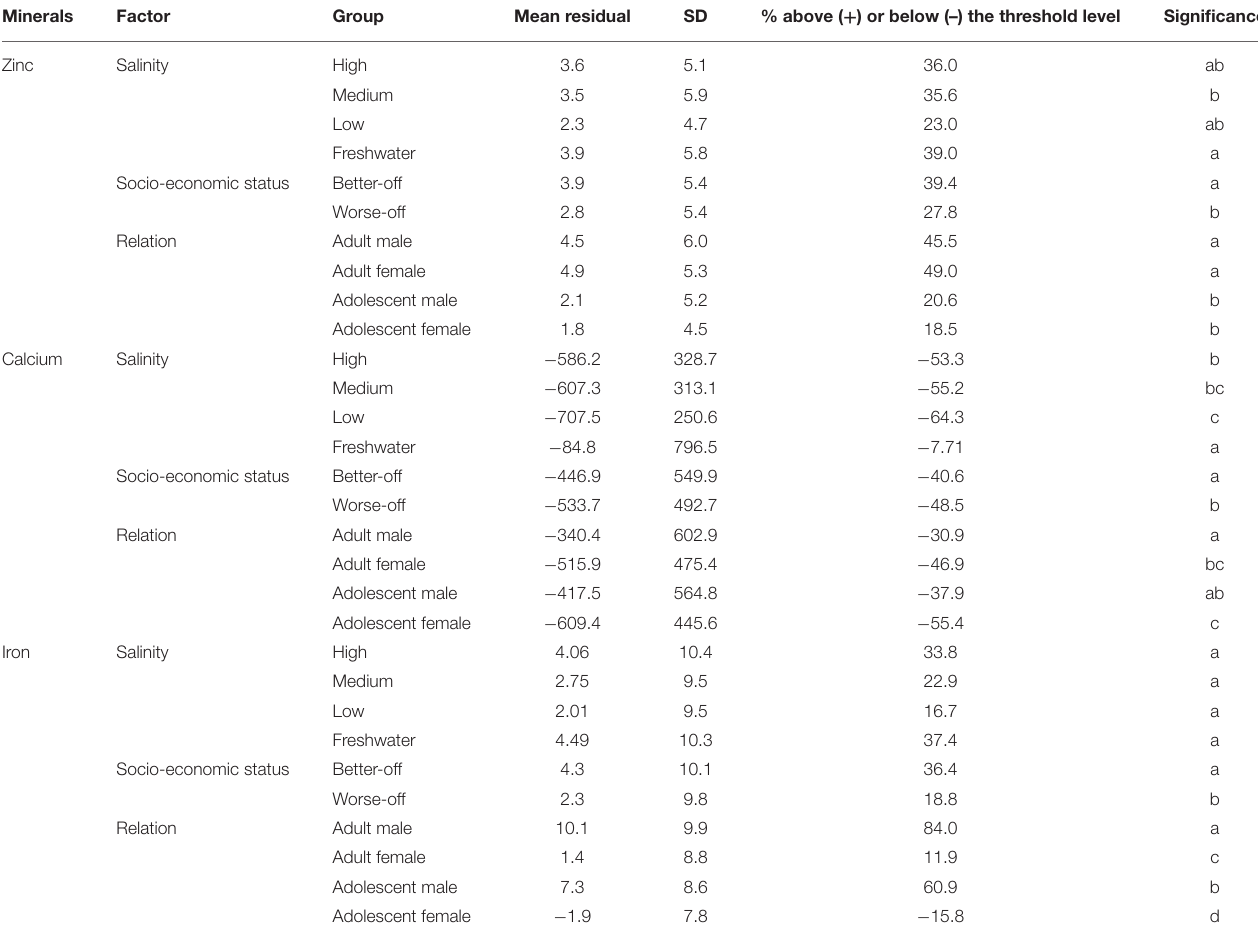
TABLE 4 | Results showing factors affecting mean micronutrients consumption of household members in relation to the average reference value in the aquatic farming system in SW Bangladesh. Minerals Factor Group Mean residual SD % above ( + ) or below (–) the threshold level